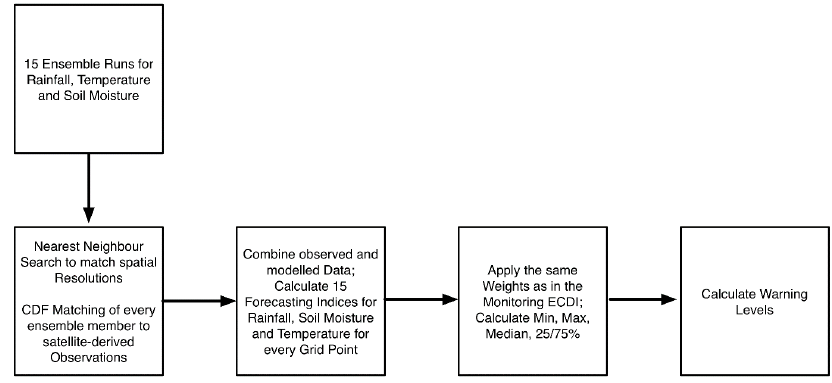
Figure 5. Flowchart illustrating the main steps in generating the forecasting component of the ECDI.